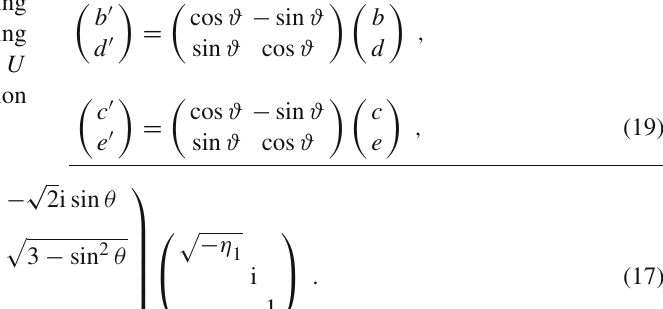
Fig. 1 In the TM1 μ - τ reflection symmetry scenario, the fitted values of a 2 , T and IO cases with η